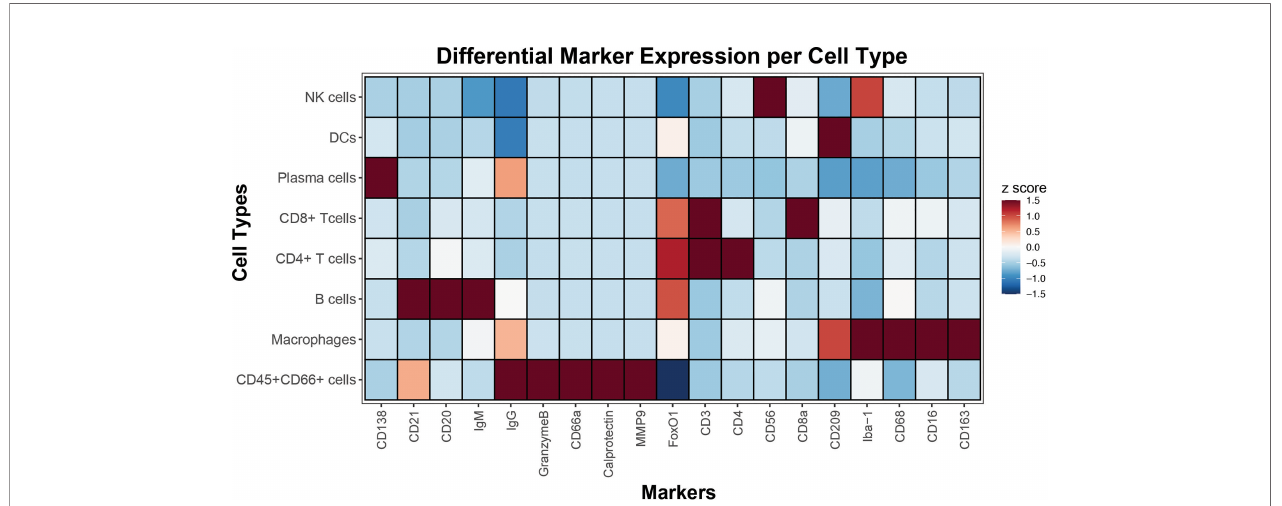
FIGURE 4 | Cell type-speci fi c marker expressions revealed by CODEX. Single-cell data extracted from segmented CODEX images of spleen from this study was used to identify major immune cell populations by gating. A heatmap displays rows signifying cell types, and columns indicative of their corresponding marker expressions. Median z scores and their corresponding color maps are shown in the key on the right.